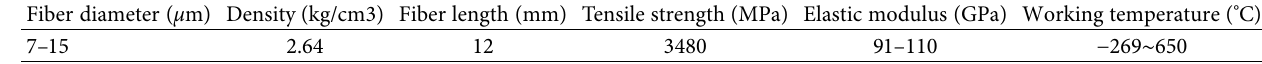
Table 3: The performance parameter of basalt fiber.